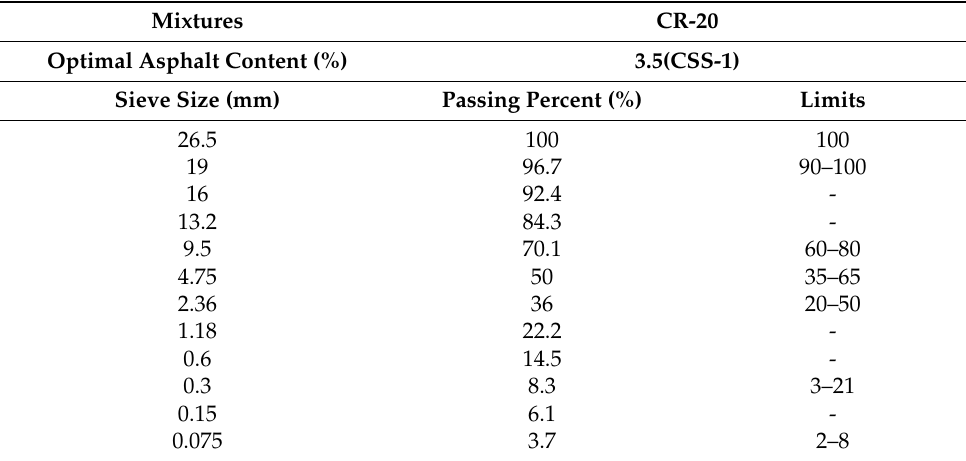
Table 1. Mix design results of the CR-20